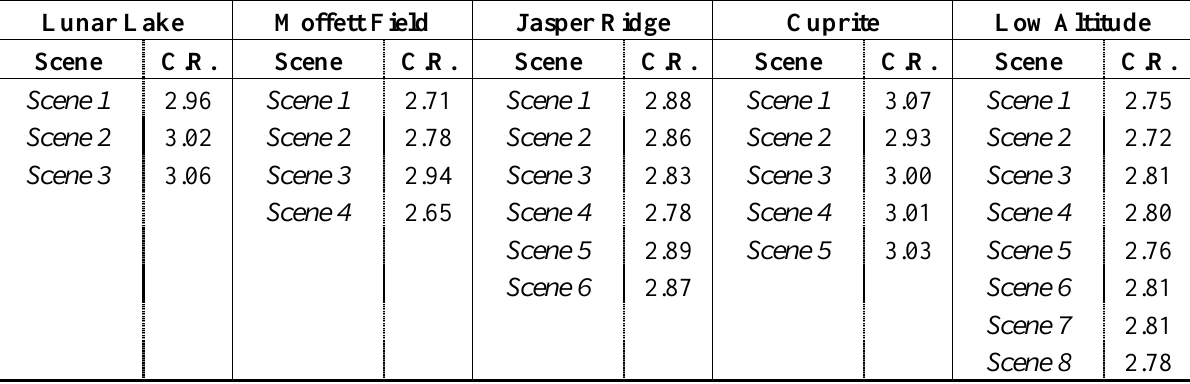
Table 3. Results (C.R. achieved for each scene of the hyperspectral imagery with Bhattacharyya distance-based band